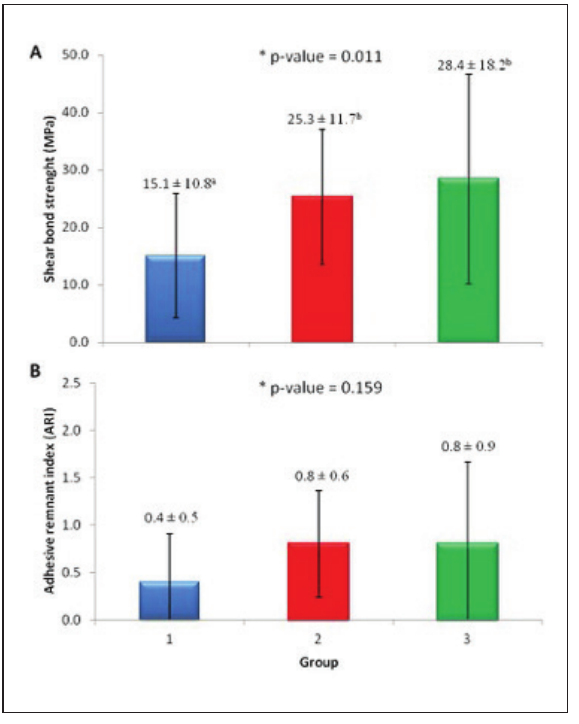
Figure 1. Comparison of shear bond strength (A) and ARI (B) between groups. Columns represent means, and error bars the standard deviations. * Kruskal-Wallis Test; a,b Values with different superscript letters indicate significant differences between the groups (Mann-Whitney test); Group 1 (Control): phosphoric acid etching, followed by primer application and fixation with Transbond XT; Group 2: deproteinisation with 3% bromelain